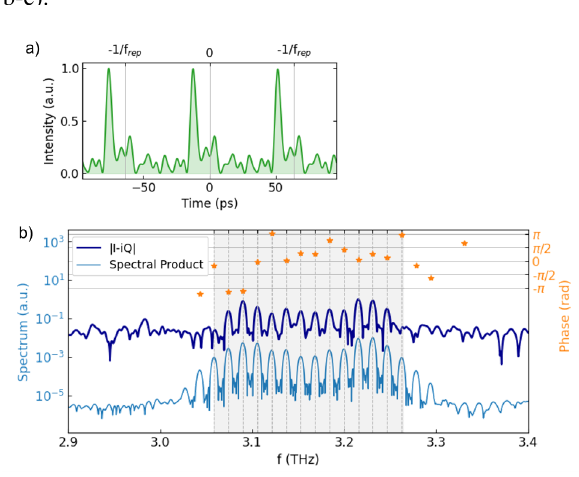
Figure 4. a) Reconstructed intensity profile of an 800 µ m radius double ring laser with bullseye antenna. The relative Spectral product (i.e. I ( ω ) I ( ω + f rep ) (light blue), SWIFT spectrum (dark blue) and the modes phases (orange stars) are reported in